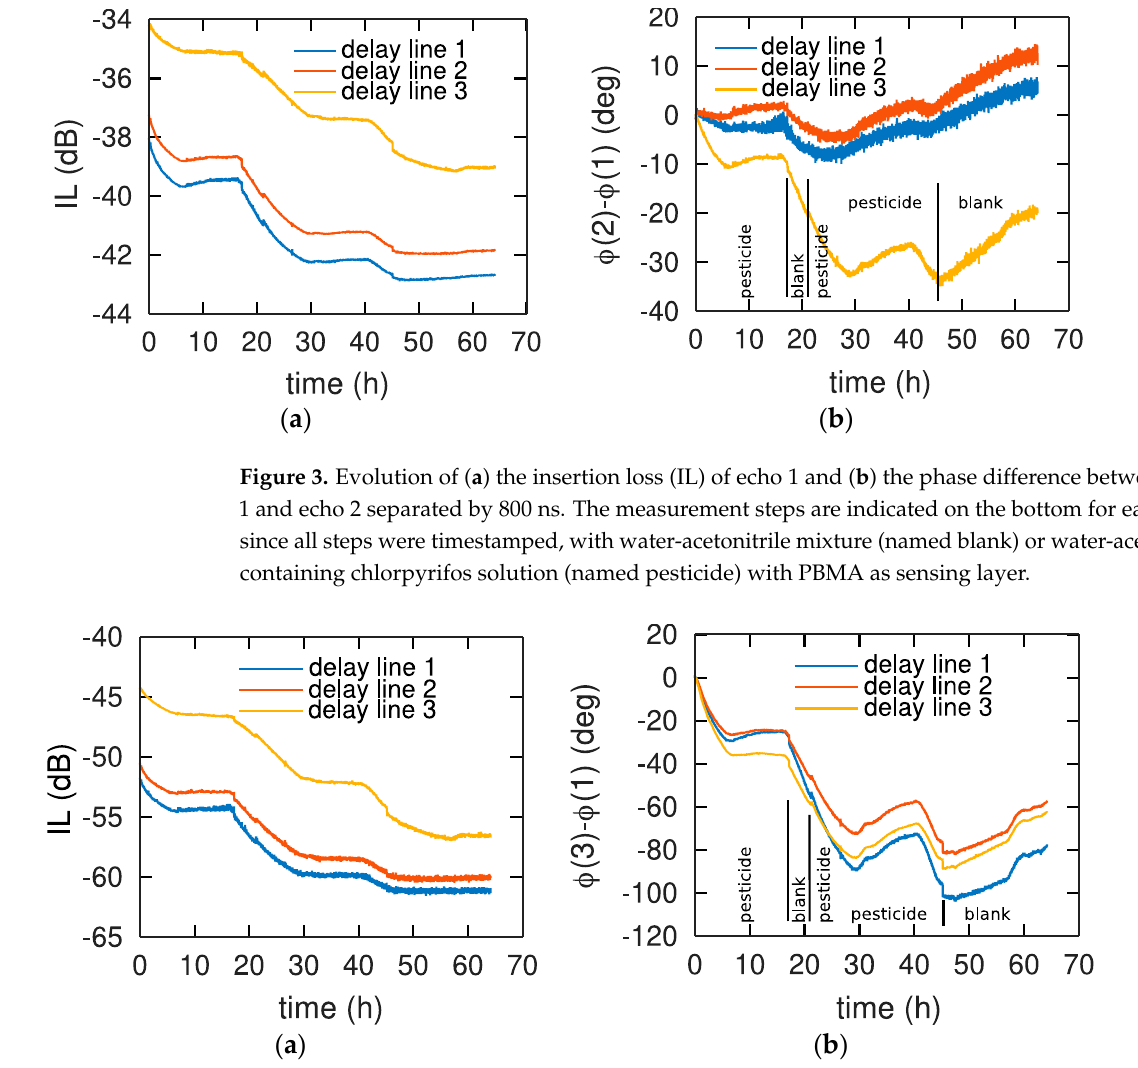
Figure 4. Evolution of ( a ) the insertion loss (IL) of echo 2 and ( b ) the phase difference between echo 2 and echo 3 separated by 1600 ns. The measurement steps are indicated on the bottom for each chart since all steps were timestamped, with water-acetonitrile mixture (named blank) or water-acetonitrile containing chlorpyrifos solution (named pesticide) with PBMA as sensing layer.